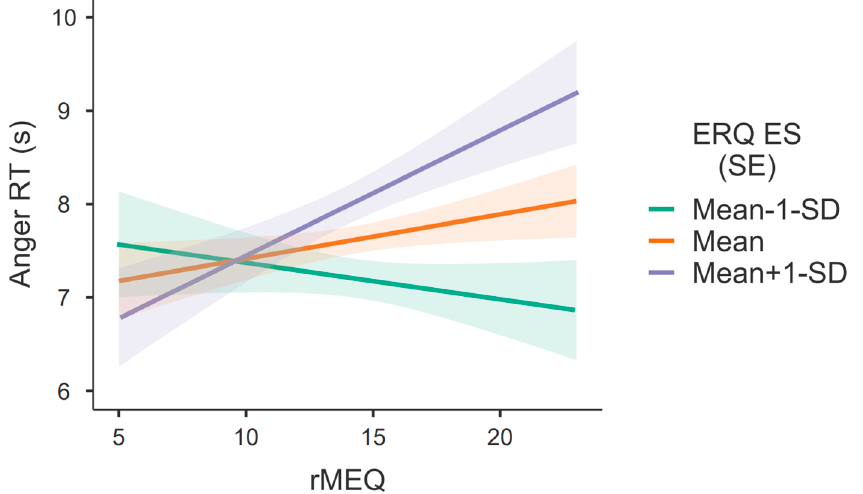
Figure 3 . Simple main effects of chronotype on response times (RT) in identifying anger from faces, according to the expressive suppression levels (Mean ± 1SD). (SE) = standard error of the mean— shaded zone surrounding the lines.